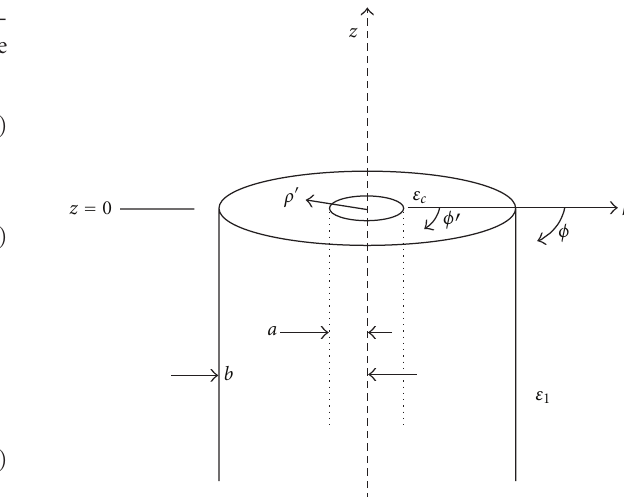
Figure 4: Illustration of the excitation of coaxial surface waves and associated